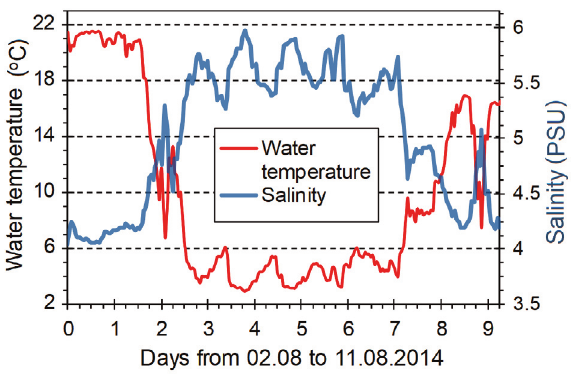
Fig. 9. Example of contrasting variations in water temperature and salinity indicating upwelling (low temperature, high salinity) recorded with the RDCP at 10 m depth near the Letipea Peninsula (see also Suursaar